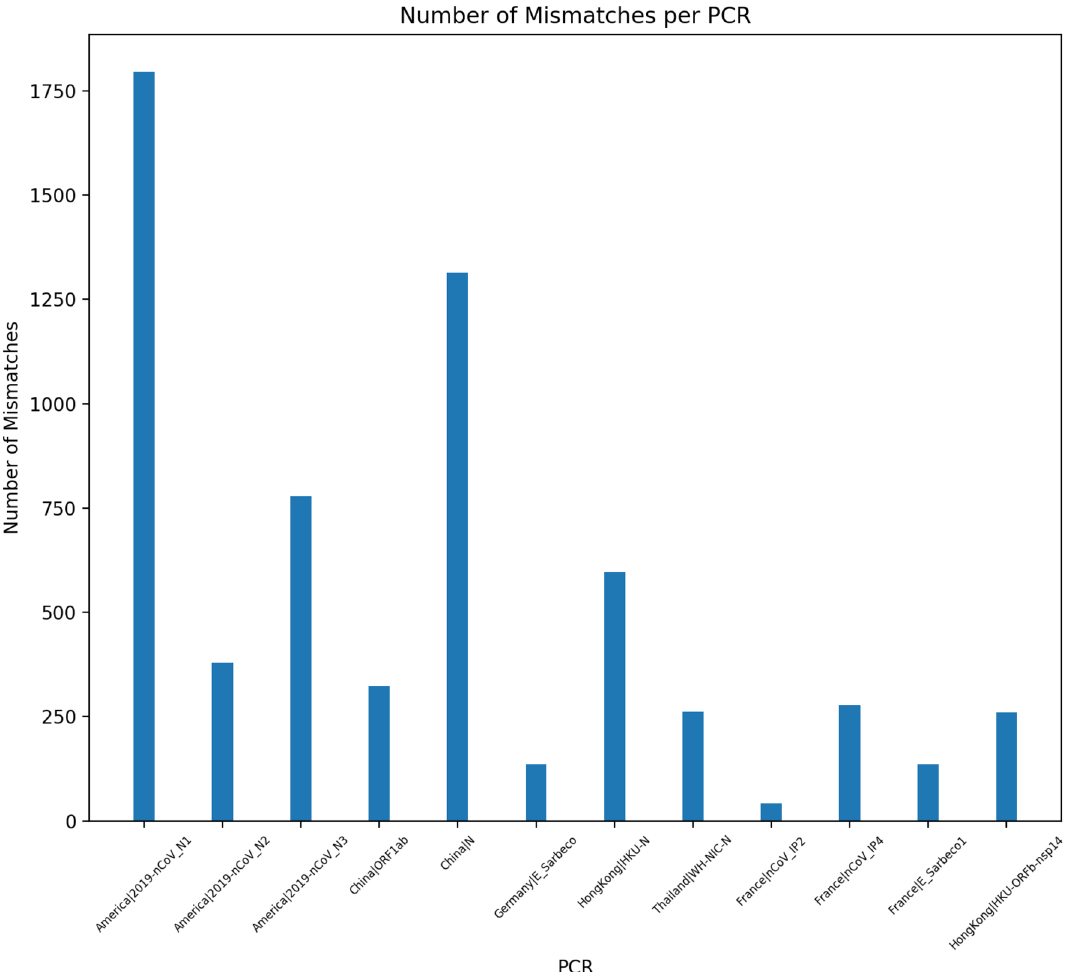
Figure 1. Total number of mismatches each PCR test creates when tested against the full corpus of SARS- CoV-2 genomes. Each PCR test is identified by the country of use and the targeted gene point represents a pairwise comparison of the difference in mismatch plotted over the difference in time. We observe that the delta mismatches grows in variance as the genomes occur further apart in time. Furthermore, the Pearson coefficient is 0.99 between mismatches and the number of genomes sampled in a day for each PCR. This positive linear relationship between the number of genomes and the number of mismatches per day shows that the mismatches occur uniformly across the genomes sampled within a day (rather than a few genomes creating noise in the signal). The data indicates that the virus demonstrated sequence variability in the targeted gene regions and that this variability causes sequence mismatches to increase over time.